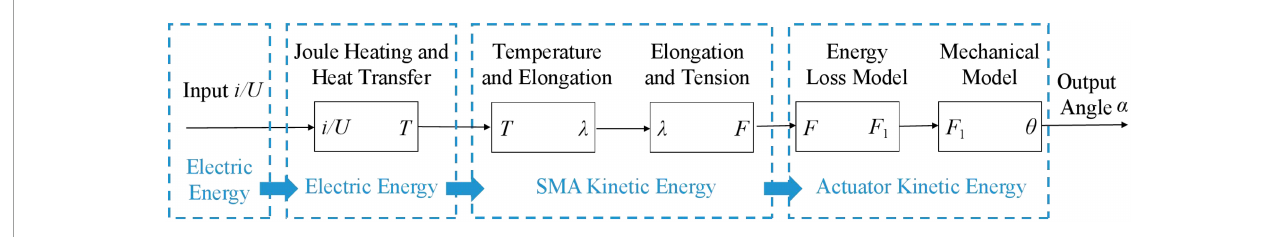
FIGURE5 Energy transfer process of the SMA-based soft composite structure. i/U: current/voltage, T: temperature, λ : elongation of SMA spring, F: contraction force of SMA spring, F1: force of manganese steel, θ : angle of SSCS, α : angle of finger.